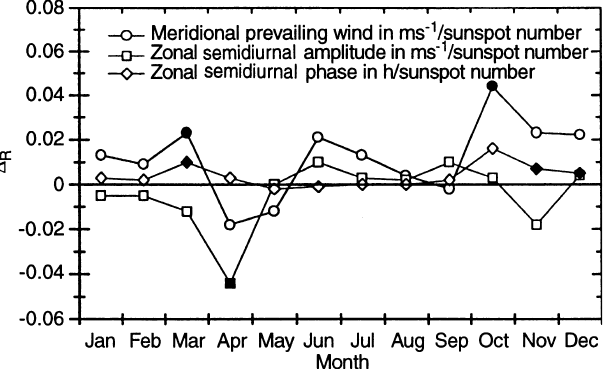
Fig. 6. Coe(cid:129)cient D (solar cycle dependence) of the meridional R prevailing wind, the zonal semidiurnal tidal amplitude and the zonal semidiurnal phase, calculated using Eq. (2) for each month. Solid symbols denote significance on the 95%-level. The coe(cid:129)cients for the meridional prevailing wind and the semidiurnal tidal amplitudes are updates after Jacobi et al.